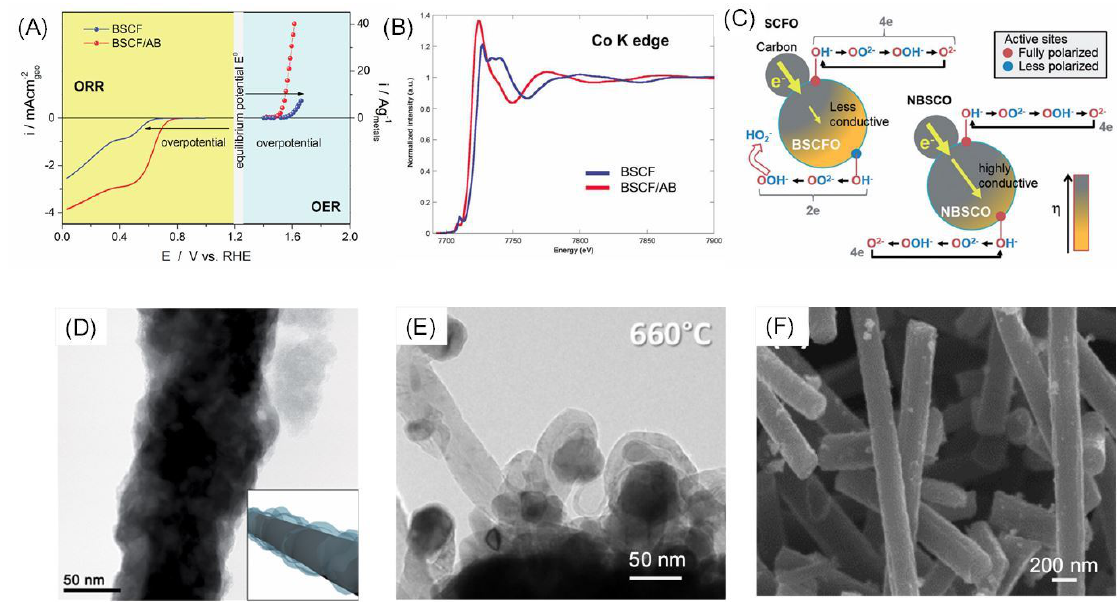
Figure6. ( A )OverallORRandOERperformanceofBa 0.5 Sr 0.5 Co 0.8 Fe 0.2 O 3 − δ (BSCF)andBSCF / acetylene black ( A , B ) composite in O 2 saturated 0.1 M KOH solution at a rotating speed of 1600 rpm with a scanning speed of 5 mV s − 1 (adapted from [93], with permission from John Wiley and Sons, 2015). ( B ) XANES spectra at the Co K edge for BSCF and BSCF / AB composite (adapted from [93], with permission from John Wiley and Sons, 2015). ( C ) Proposed ORR mechanism on a carbon supported perovskite oxide electrocatalyst (adapted from [96], with permission from John Wiley and Sons, 2015). ( D ) TEM image of the cloud-like graphene nanoplatelet functionalized Nd 0.5 Sr 0.5 CoO 3 − δ nanorod electrocatalyst (adapted from [97]) ( E ) TEM image of the CVD grown nitrogen doped carbon coated La 0.58 Sr 0.4 Fe 0.2 Co 0.8 O 3 electrocatalyst (adapted from [98], with permission from Elsevier, 2016). ( F ) SEM image of the nitrogen doped carbon nanotube embedded with LaTi 0.65 Fe 0.35 O 3 − δ (adapted from